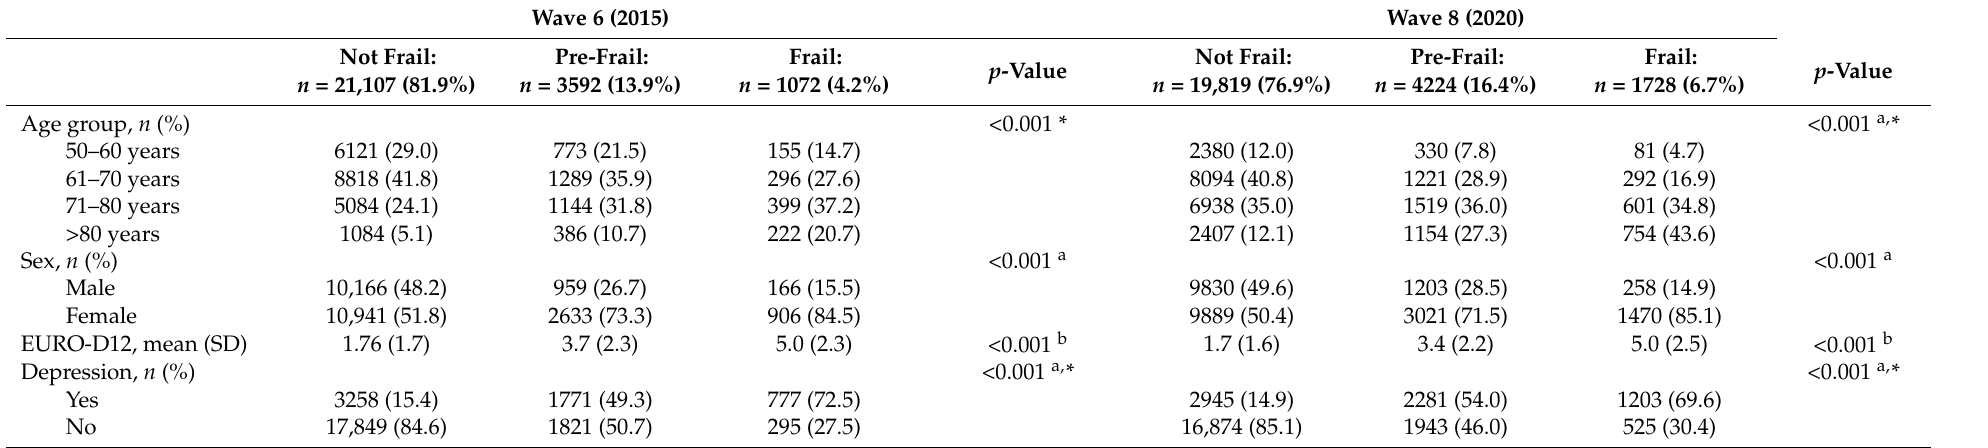
Table 2. Sample characteristics of SHARE participants according to frailty classification in 2015 and in 2020 ( n = 25,771).